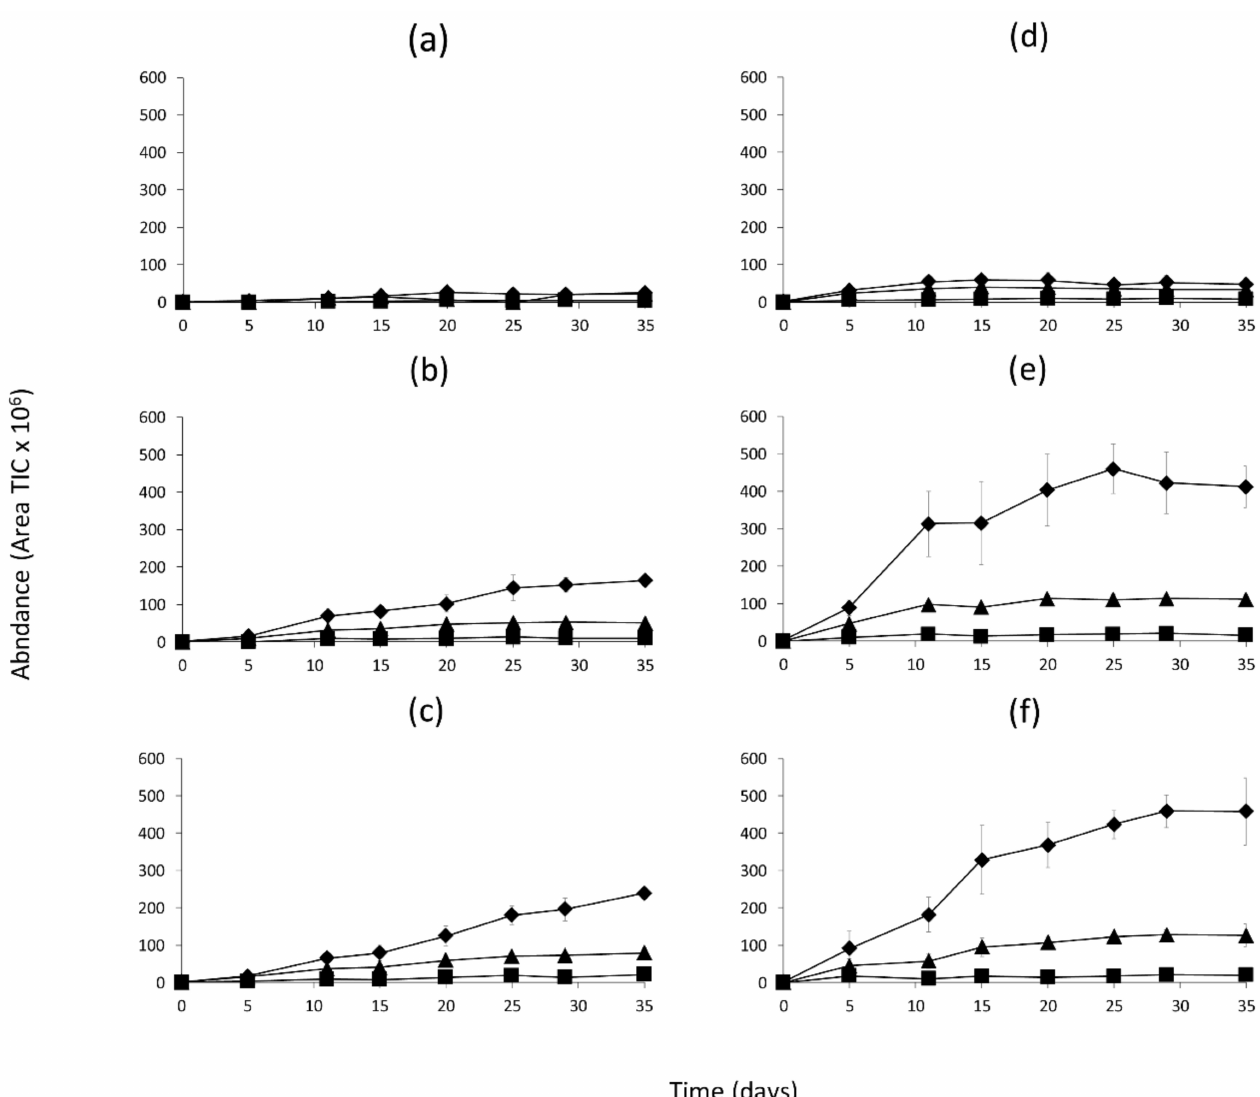
Figure 1. Abundance of volatile compounds derived from Val, Ile and Leu in the model systems during incubation at 25 or 37 ◦ C and classified according to the dry curing stages (I-Initial stage, 1D-1st drying stage, 2D-2nd drying stage). ( a ) I-25 ◦ C, ( b ) 1D-25 ◦ C, ( c ) 2D-25 ◦ C, ( d ) I-37 ◦ C, ( e ) 1D-37 ◦ C, ( f ) 2D-37 ◦ C. Symbols represent the different compounds: 2-Methylpropanal ( (cid:4) ); 3-Methylbutanal ( (cid:7) ); 2-Methylbutanal ( (cid:78)